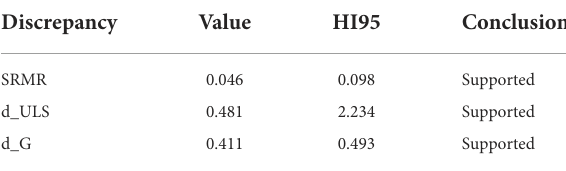
TABLE 3 The demographics of the